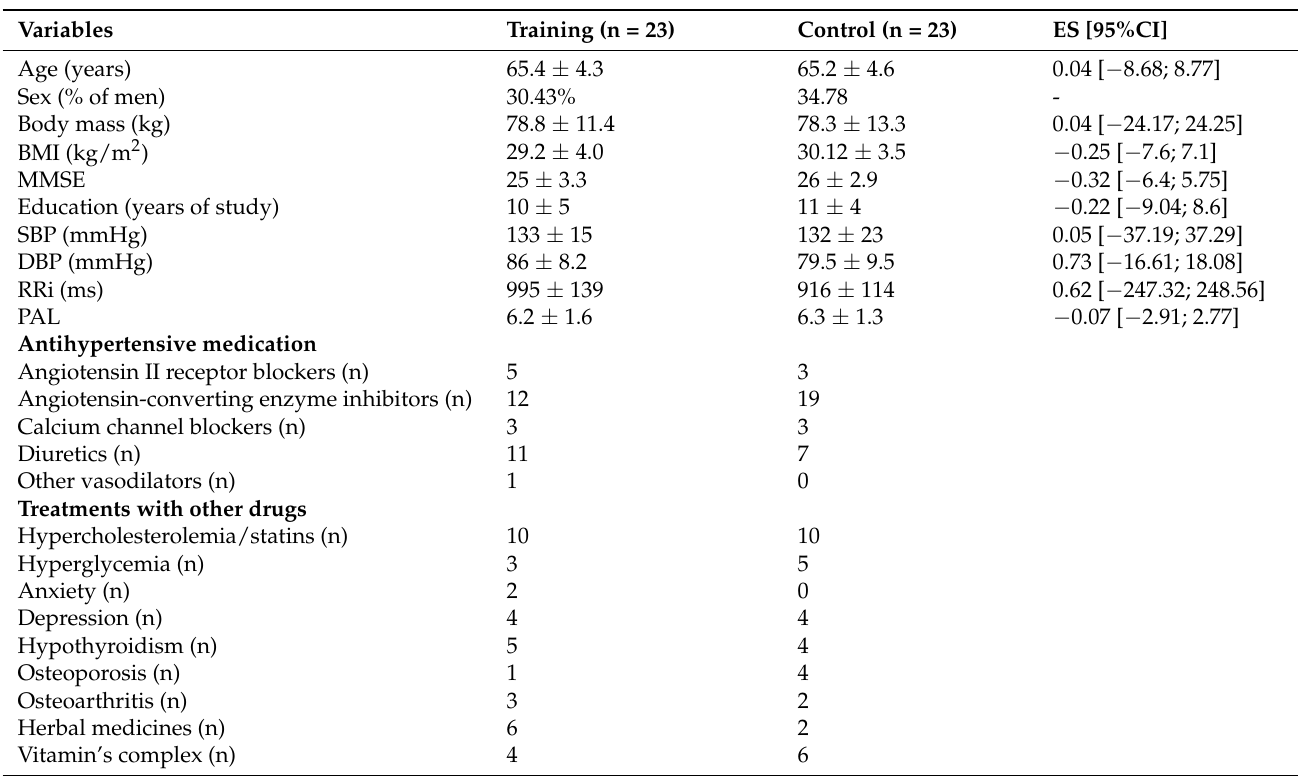
Table 1. Baseline